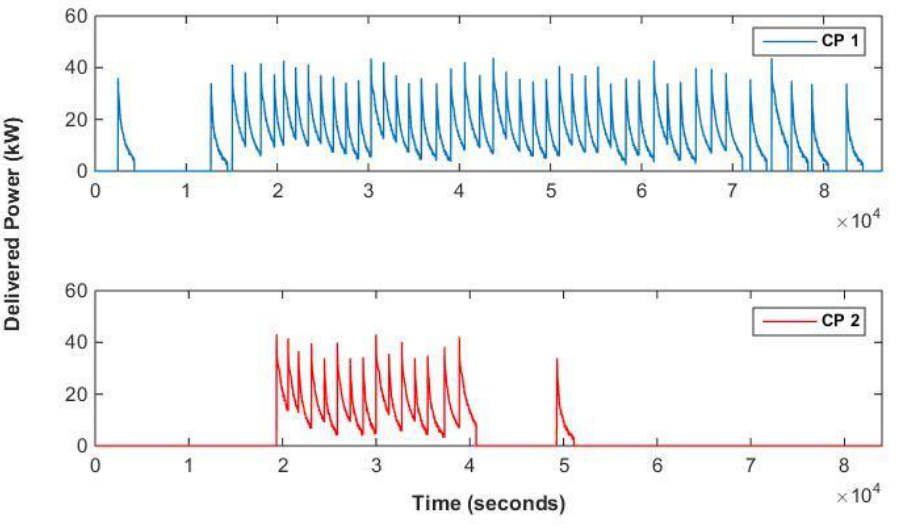
Figure 11. Charge profiles of CP 1 and 15 of station 3 for scenario (0, 10, 15).